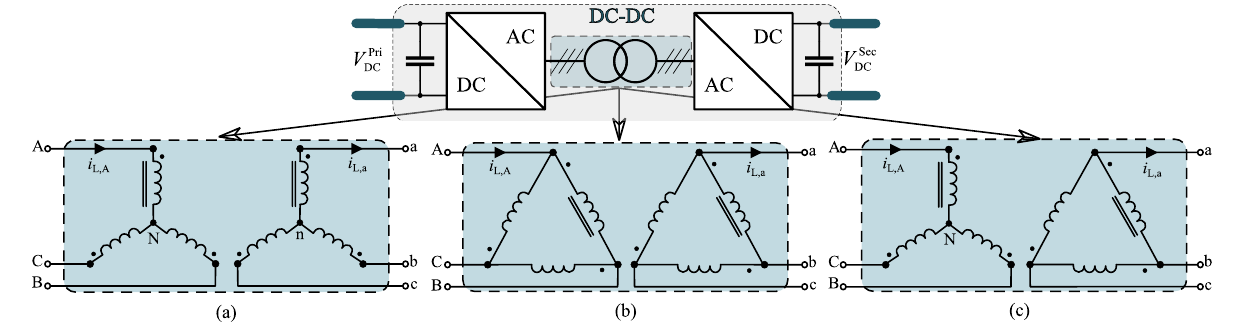
Figure 1. Topology of a 3 φ DAB dc–dc converter with different transformer winding configurations. ( a ) YY configuration. ( b ) ∆∆ configuration. ( c ) Y ∆ configuration.